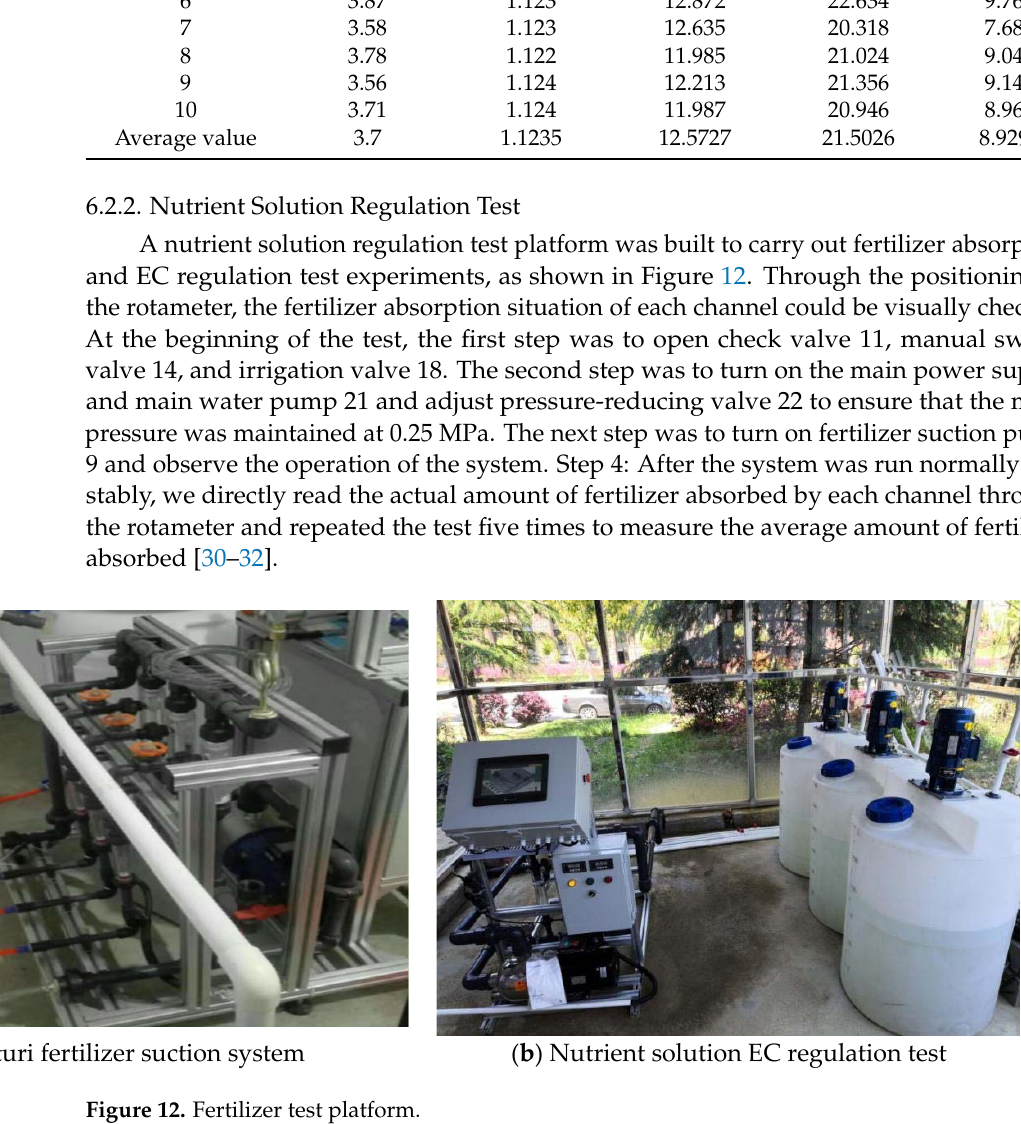
Figure 12. Fertilizer test platform.